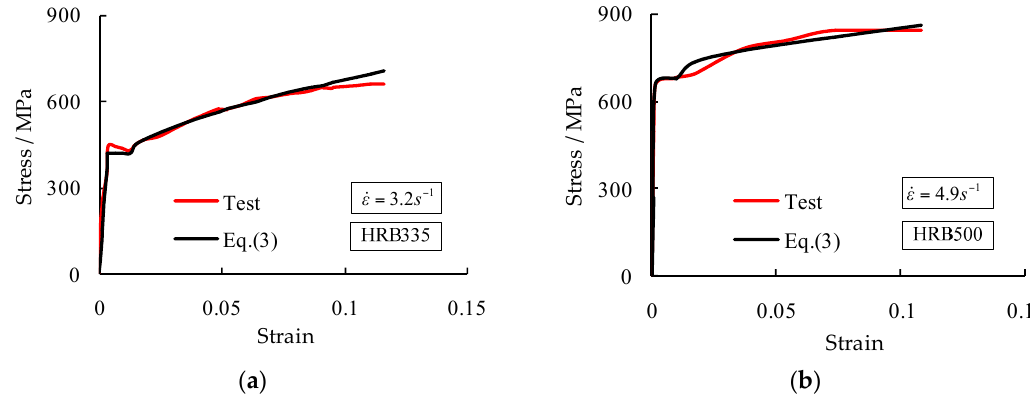
Figure 6. Typical stress-strain curves obtained from testing and Equation (3) for rebar grade HRB335 at a strain rate of 3.2 s − 1 ( a ) and for rebar grade HRB500 at a strain rate of 4.9 s − 1 ( b ).